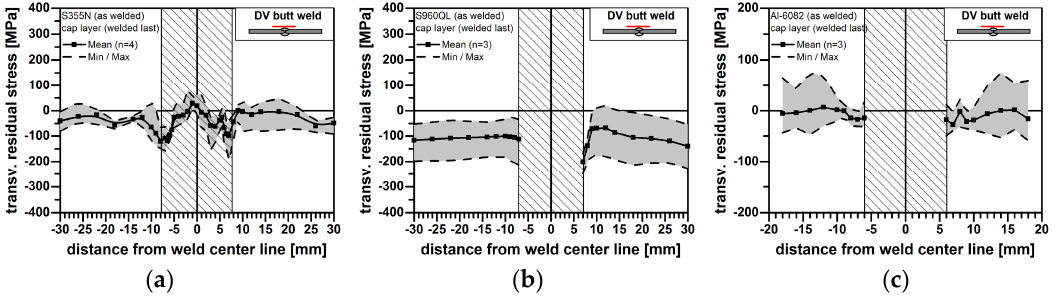
Figure 3. Residual stress at surface of DV-butt welds made from S355N ( a ), S960QL ( b ), and Al-6082 ( c ). Hachures indicate the weld seam width.